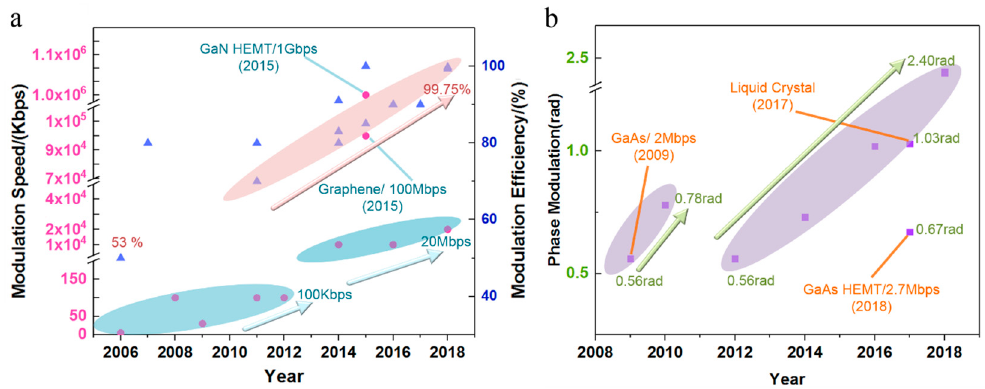
Figure 3. Progress of terahertz (THz) amplitude modulators ( a ) and transmitted phase modulators ( b ).